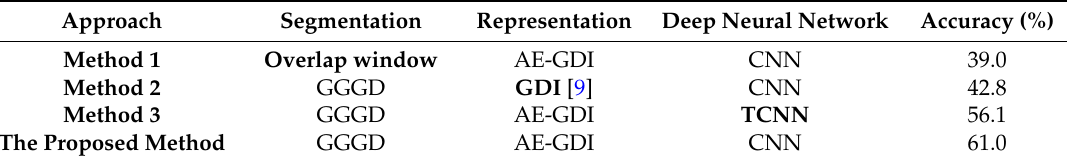
Table 2. Gait Labeling Accuracy in complete subjects